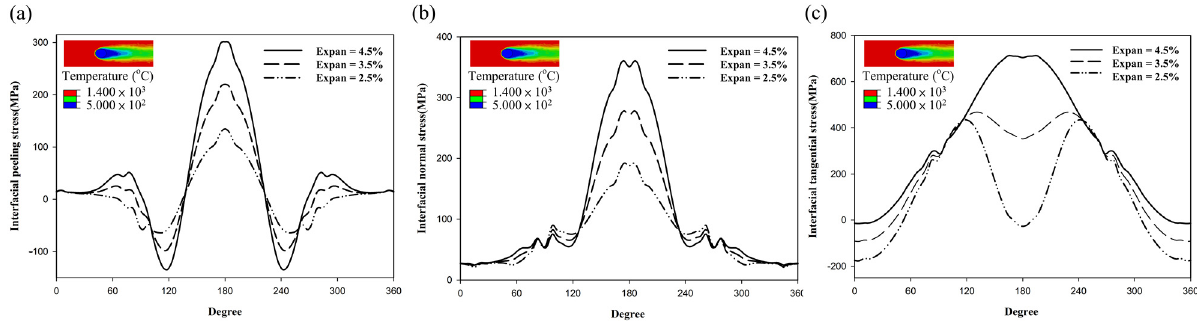
Figure 11. ( a ) Peeling stress, ( b ) interfacial normal stress, and ( c ) interfacial tangential stress along the BC top surface around the cooling hole with different expansion